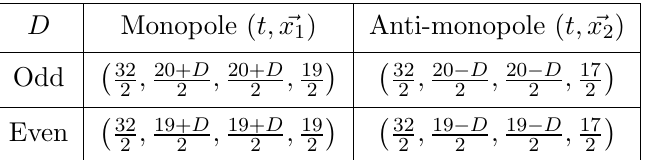
Table 1 . The locations of the monopole ( t; ~x 1 ) and anti-monopole ( t; ~x 2 ). The time t indicates the time slice in which we add the monopole and anti-monopole. The distance between the monopole and anti-monopole is indicated as D (in lattice units). The lattice volume is V = 18 3 (cid:2) 32. to the predictions of the instanton e(cid:11)ects on the observables. Finally, we estimate the catalytic e(cid:11)ect on the pion